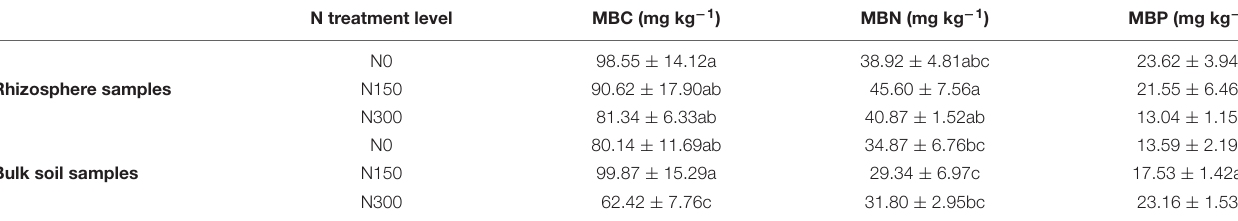
TABLE 3 | Soil microbial biomass content of rhizosphere and bulk soil samples subjected to the three nitrogen (N) fertilization levels. N treatment level